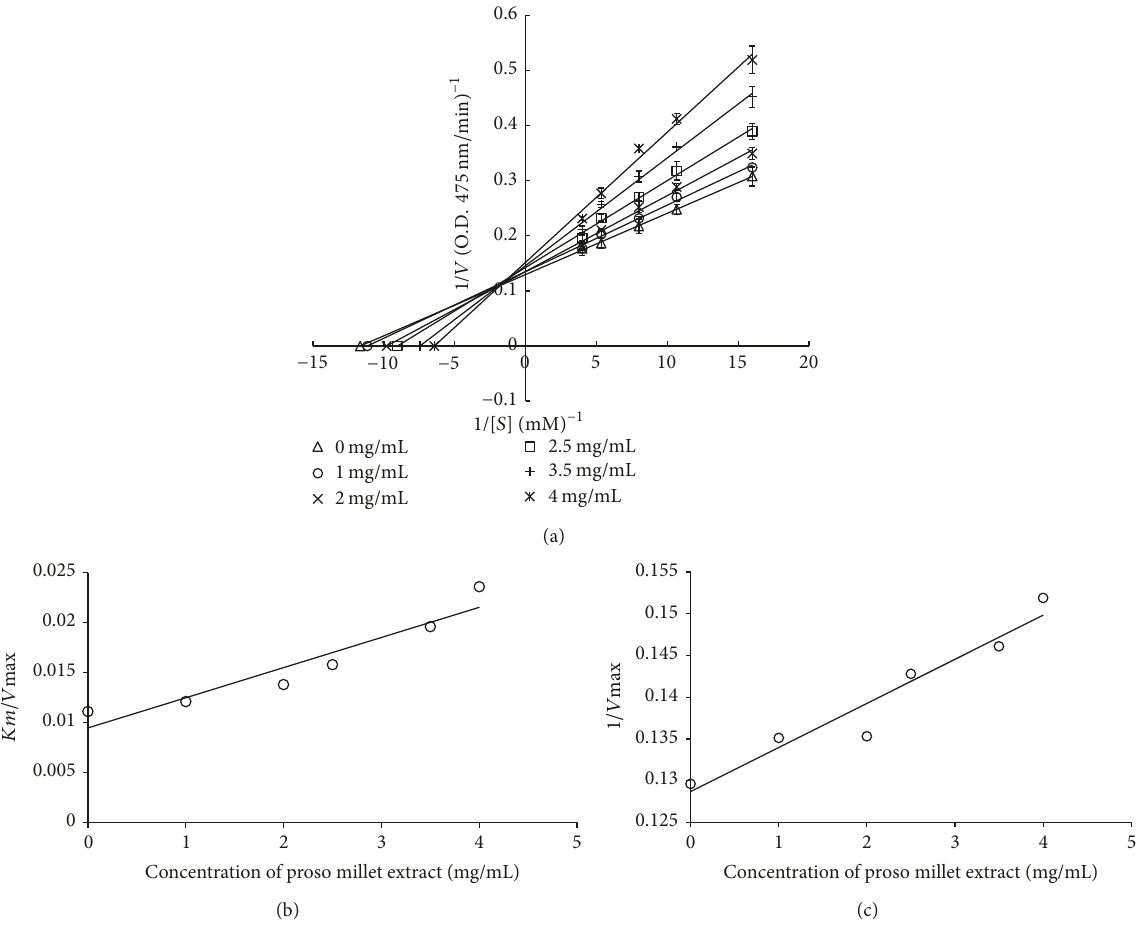
Figure5:(a)Lineweaver-Burkdoublereciprocalplotoftheeffectofprosomilletextractconcentration(0 ∼ 4 mg/mL)ontyrosinaseactivity.(b) Apparent 𝐾 𝑚 /𝑉 max as a function of proso millet extract concentration. (c) Apparent 1/𝑉 max as a function of proso millet extract